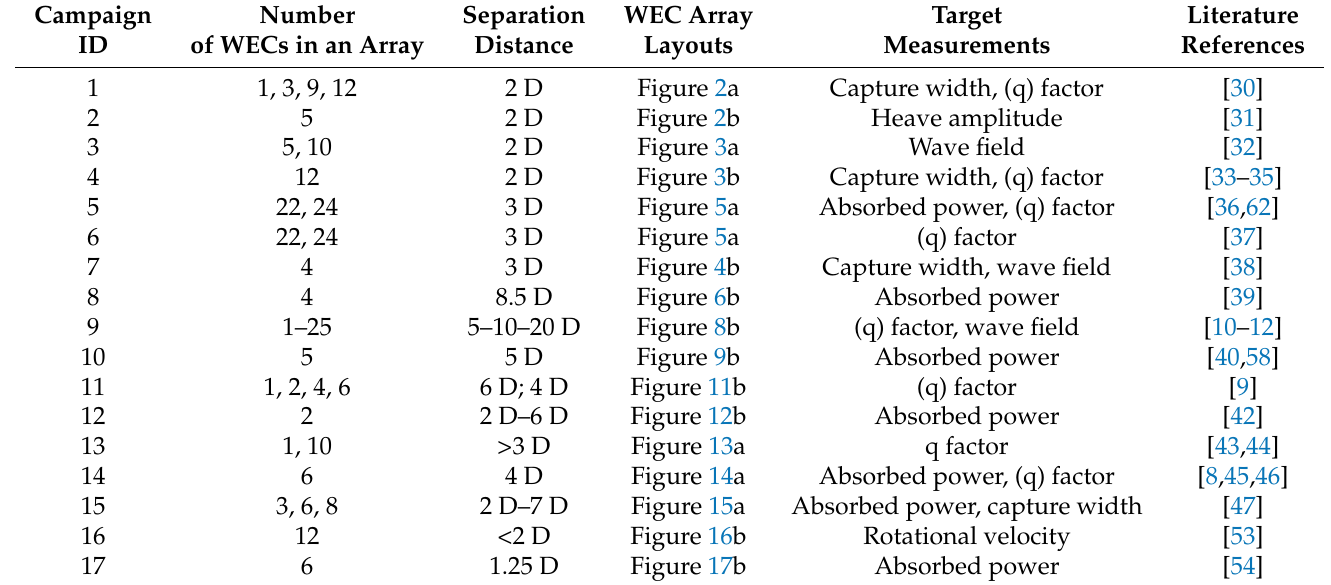
Table 4. Overview of the WEC array characteristics of the WEC array experimental campaigns